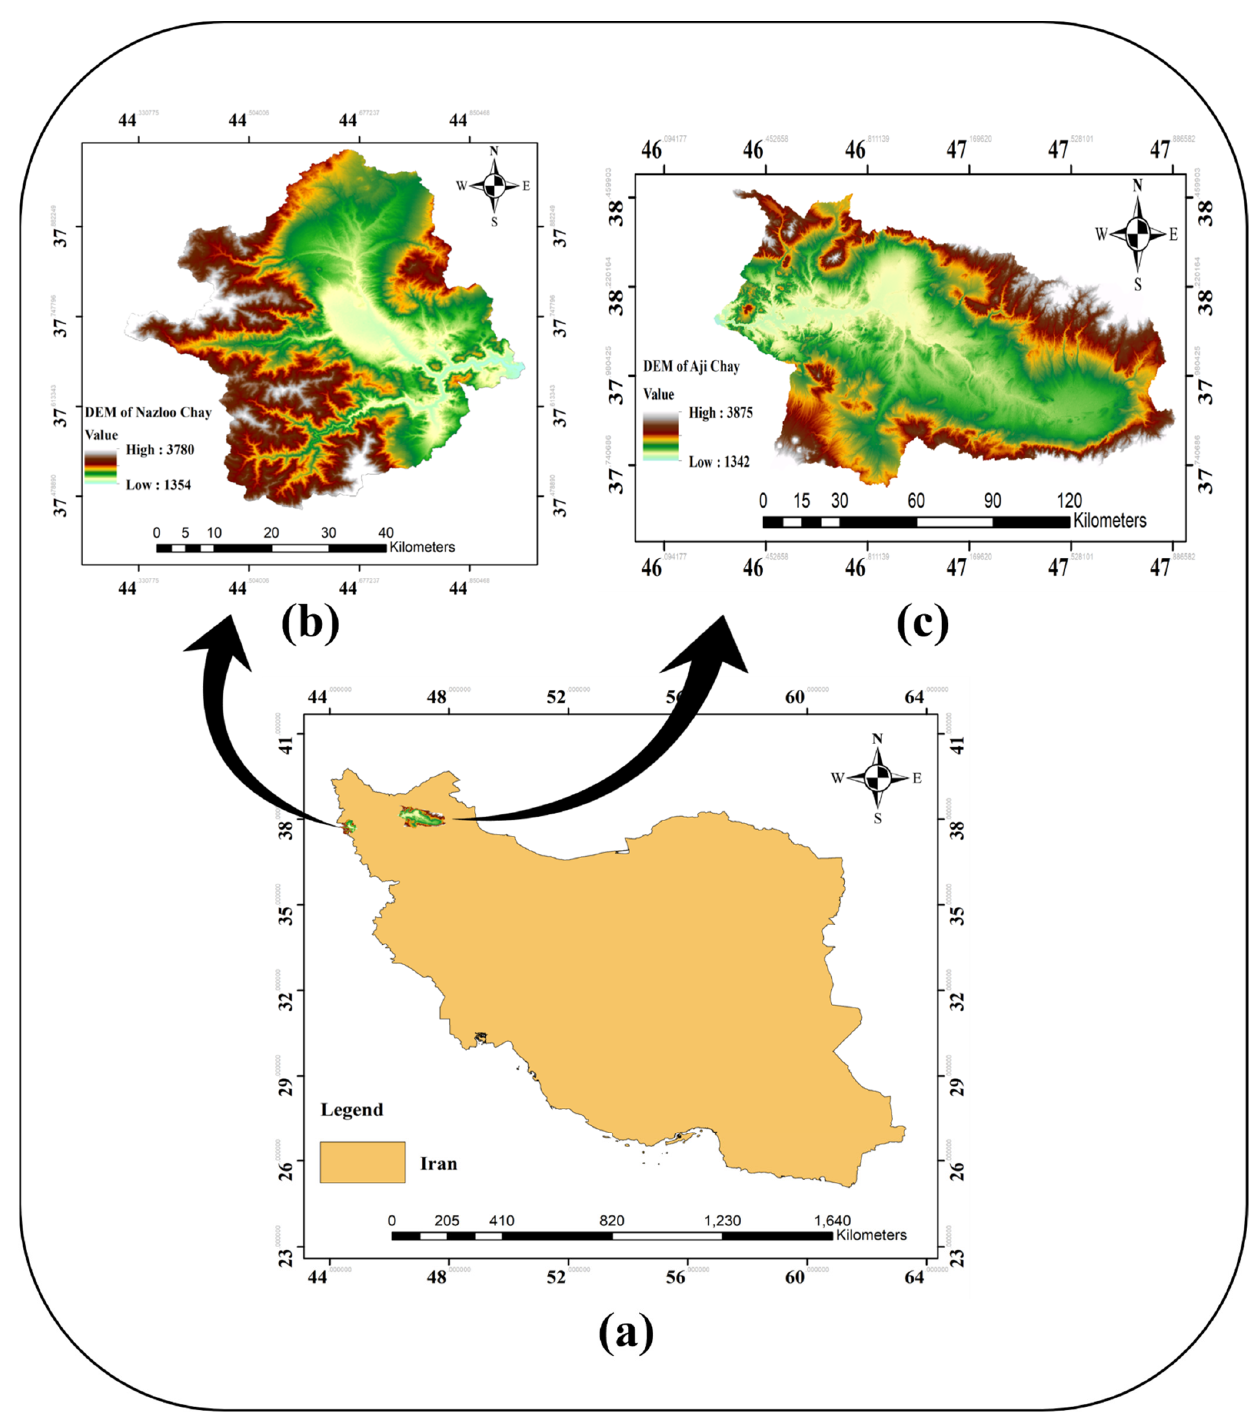
Figure 2. Location of the Aji-Chay and Nazloo-Chay watersheds. Figure 2. Location ( a ) of the Nazloo-Chay ( b ) and Aji-Chay ( c )